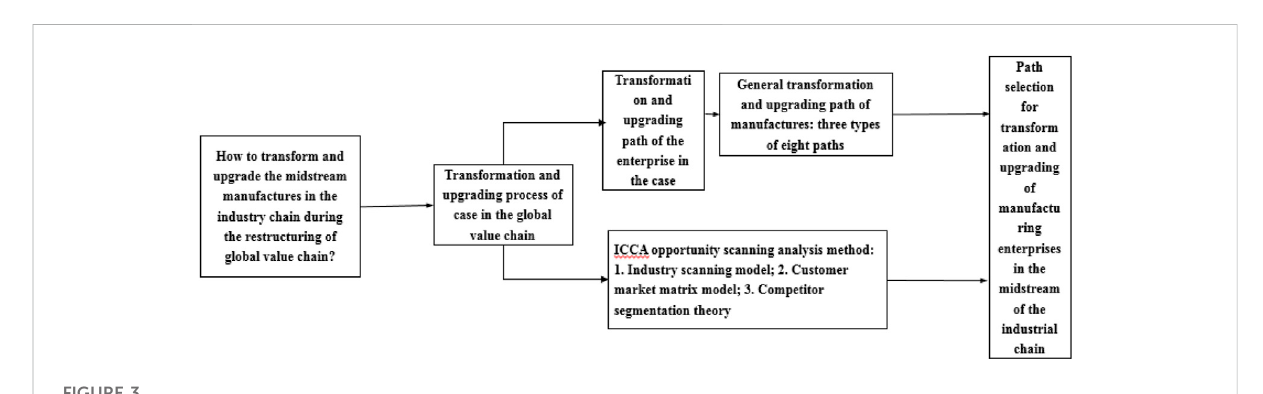
FIGURE 3 Analysis